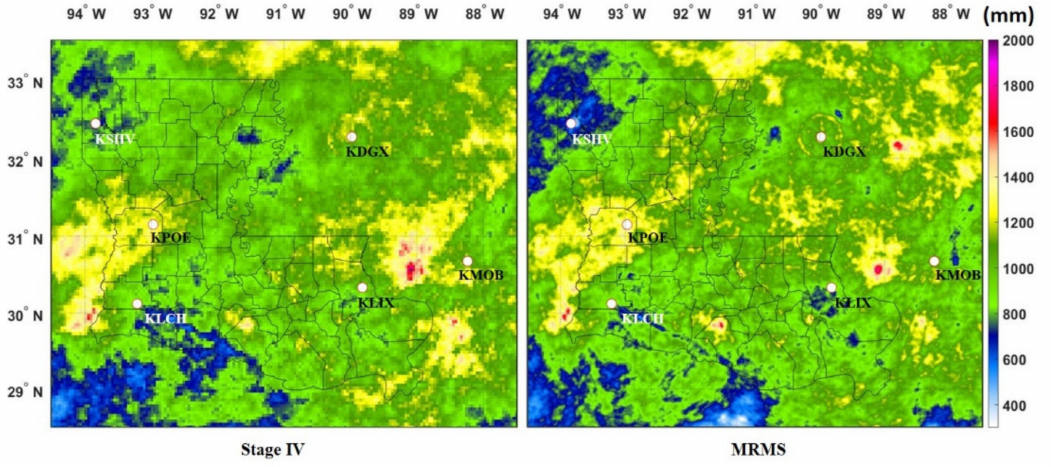
Figure 5. Spatial rainfall accumulation maps (millimeters) of Stage IV (left) and MRMS (right) for the period January through August of